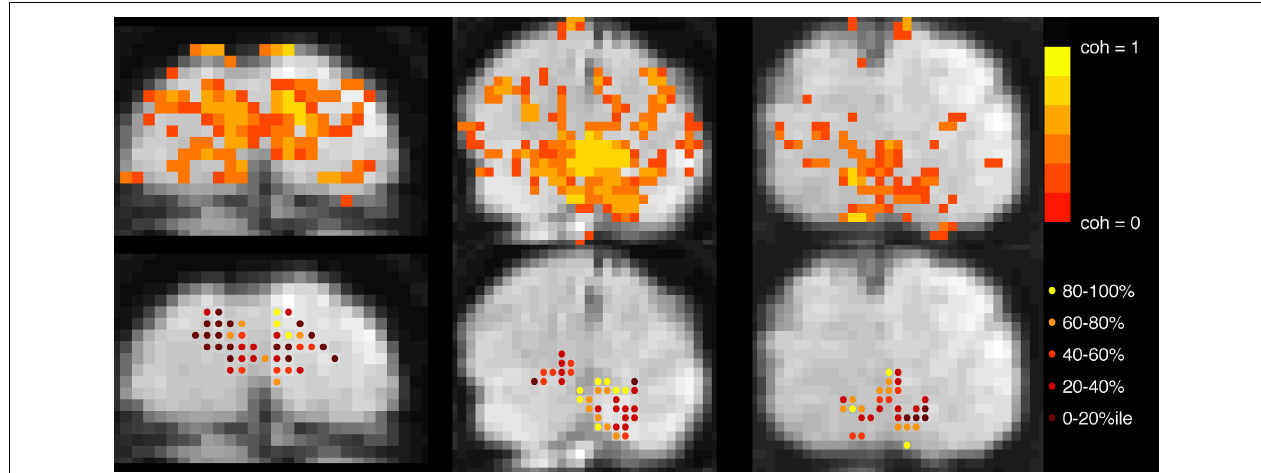
FIGURE 2 | Voxel selection. Top row : Voxels with coherence > 0.30 during localizer scan are shown in color overlay. Gray-scale images are motion- and distortion-compensated EPI data from successive slices in the Trio scanner (left and right images) and, Skyra (middle image). Bottom row : Each active